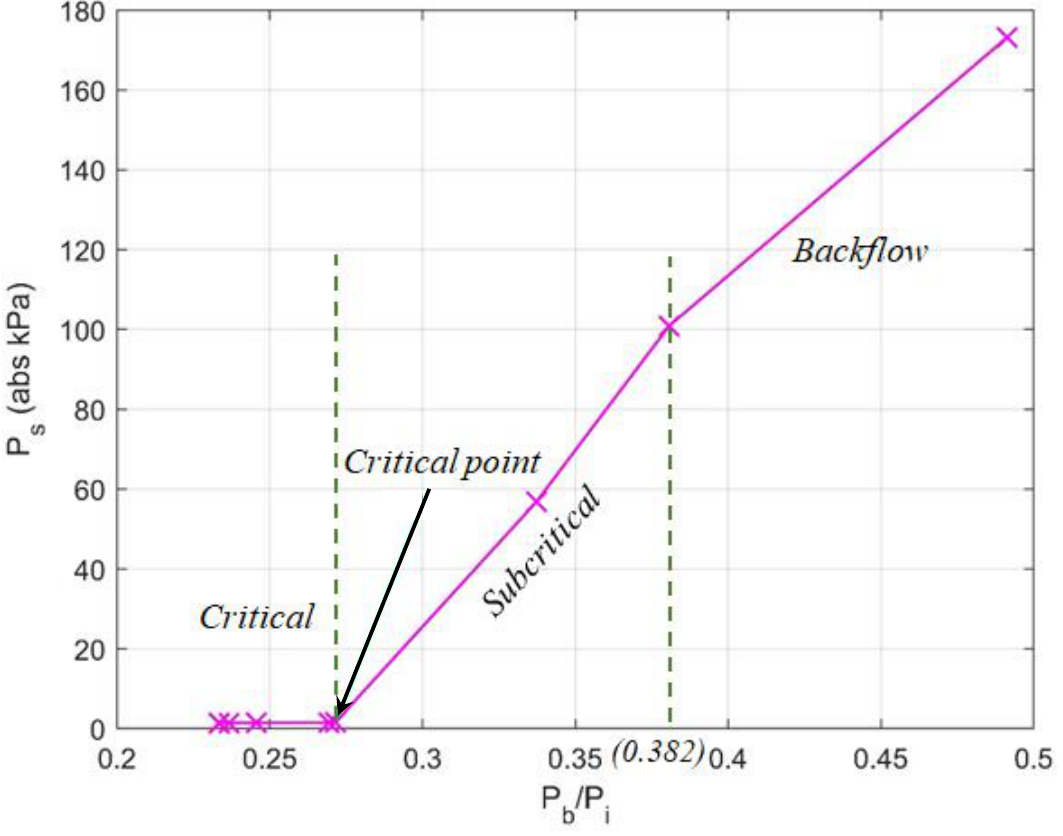
Figure 6. Experimental study of the suction capacity of an educator.